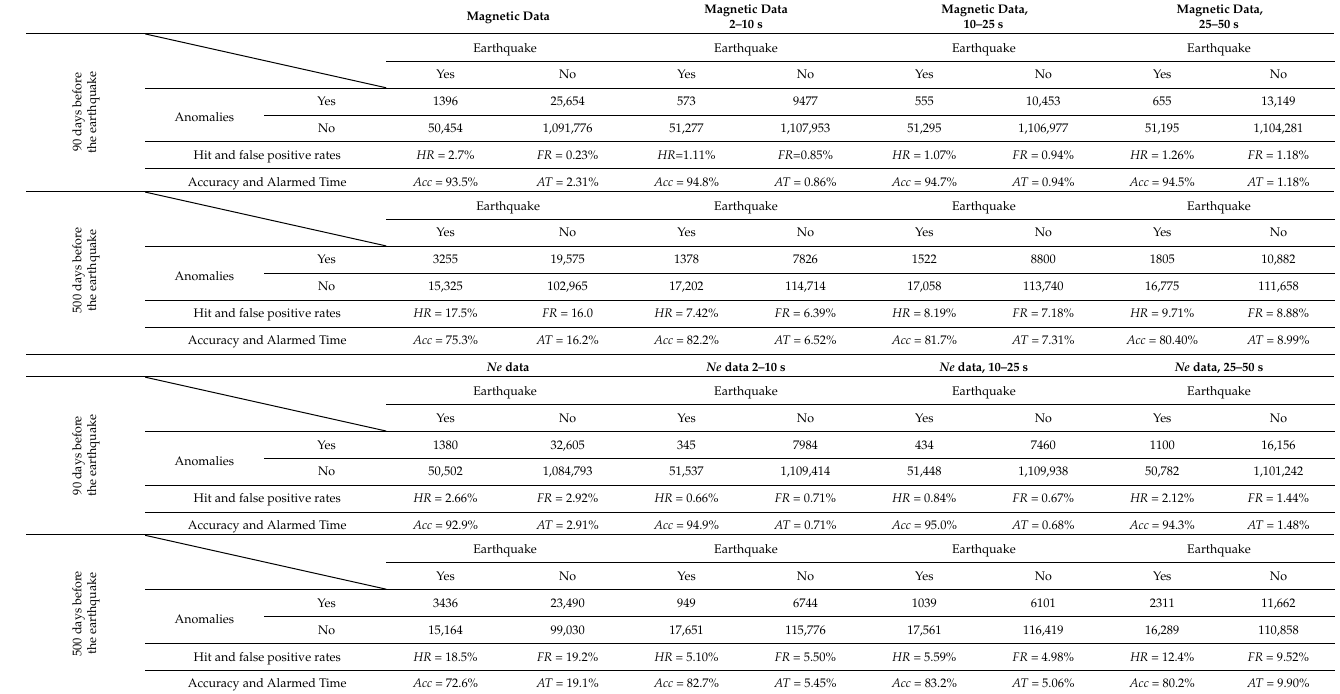
Table 1. Confusion matrices of the Swarm magnetic field and electron density anomalies identified in the 90 days or 500 days before the M5.5+ earthquakes.